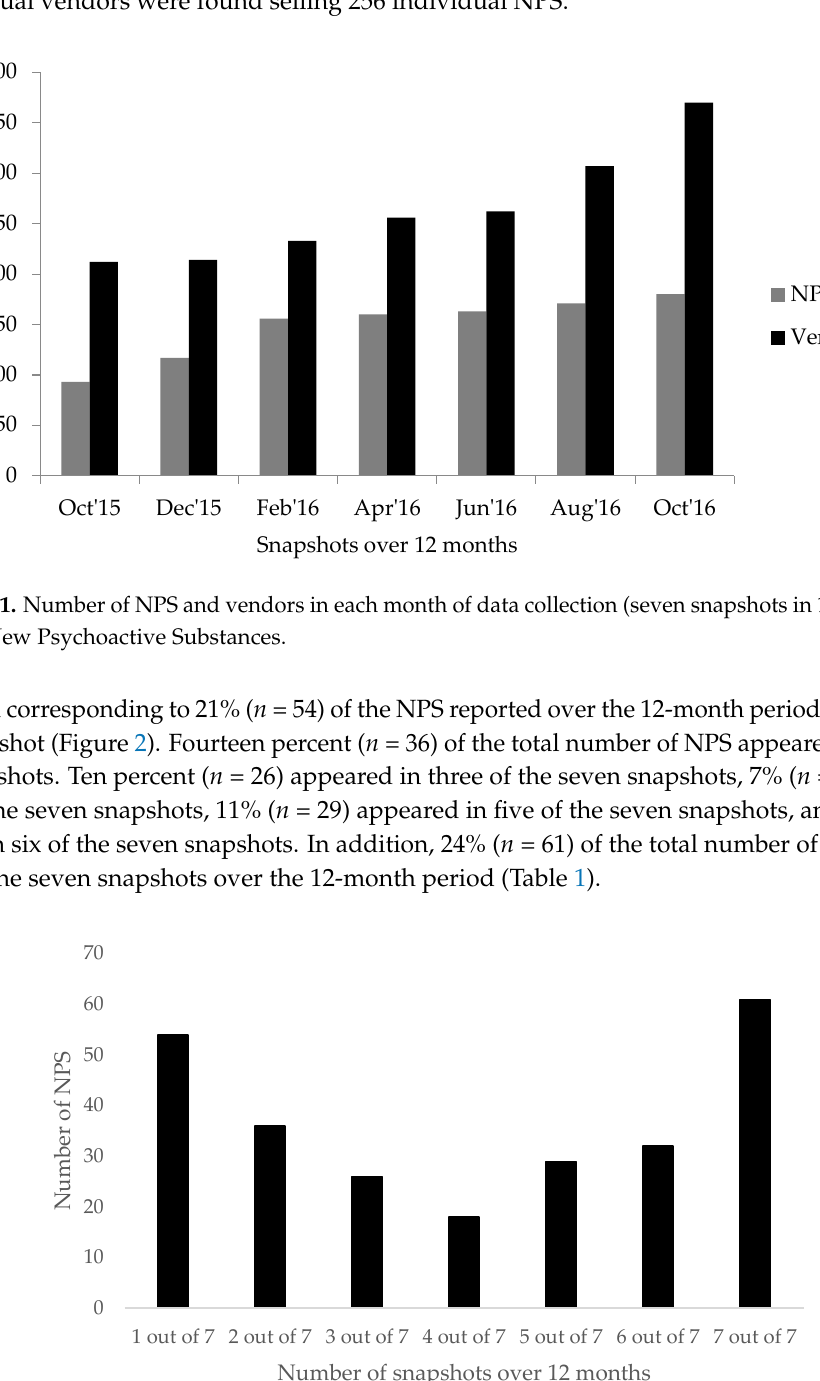
Figure 2. The number of NPS available across the seven snapshots (12 months) of data collection. NPS: New Psychoactive Substances.